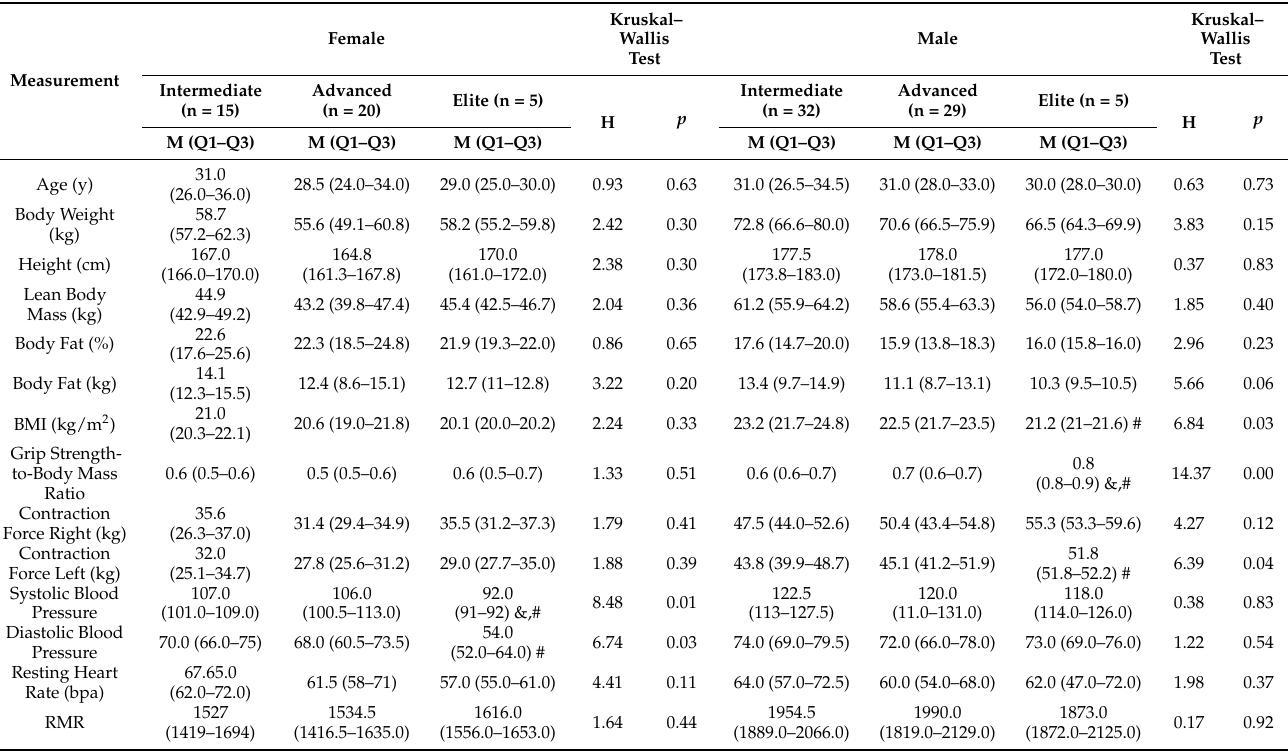
Table 1. Characteristics of study groups.